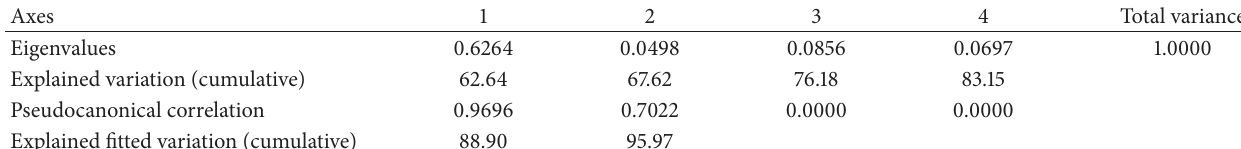
Table 3: Eigenvalues for RDA axis and environmental indexes correlations.